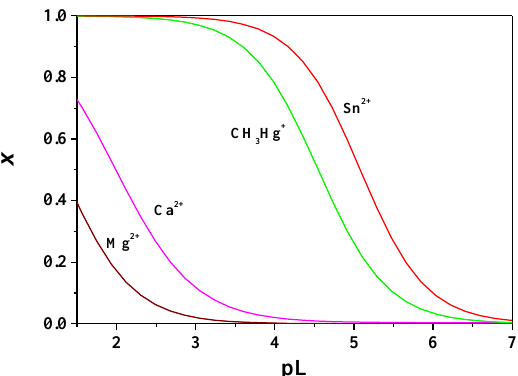
Figure 10. Sequestering diagram of dopamine towards the metal ions here investigated, at I = 0.15 mol L − 1 , T = 298.15 K, and pH = 9.0.